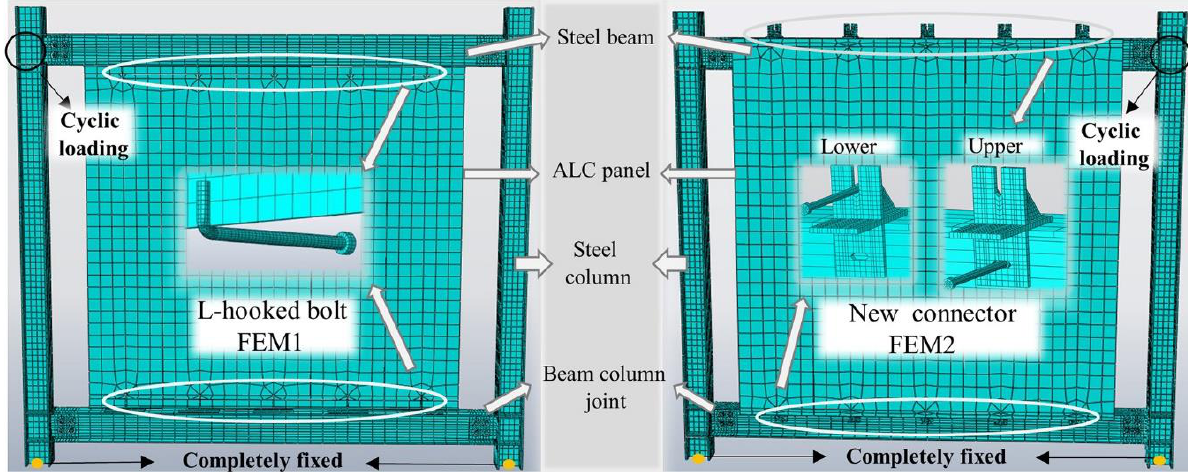
Figure 13. Finite element analysis